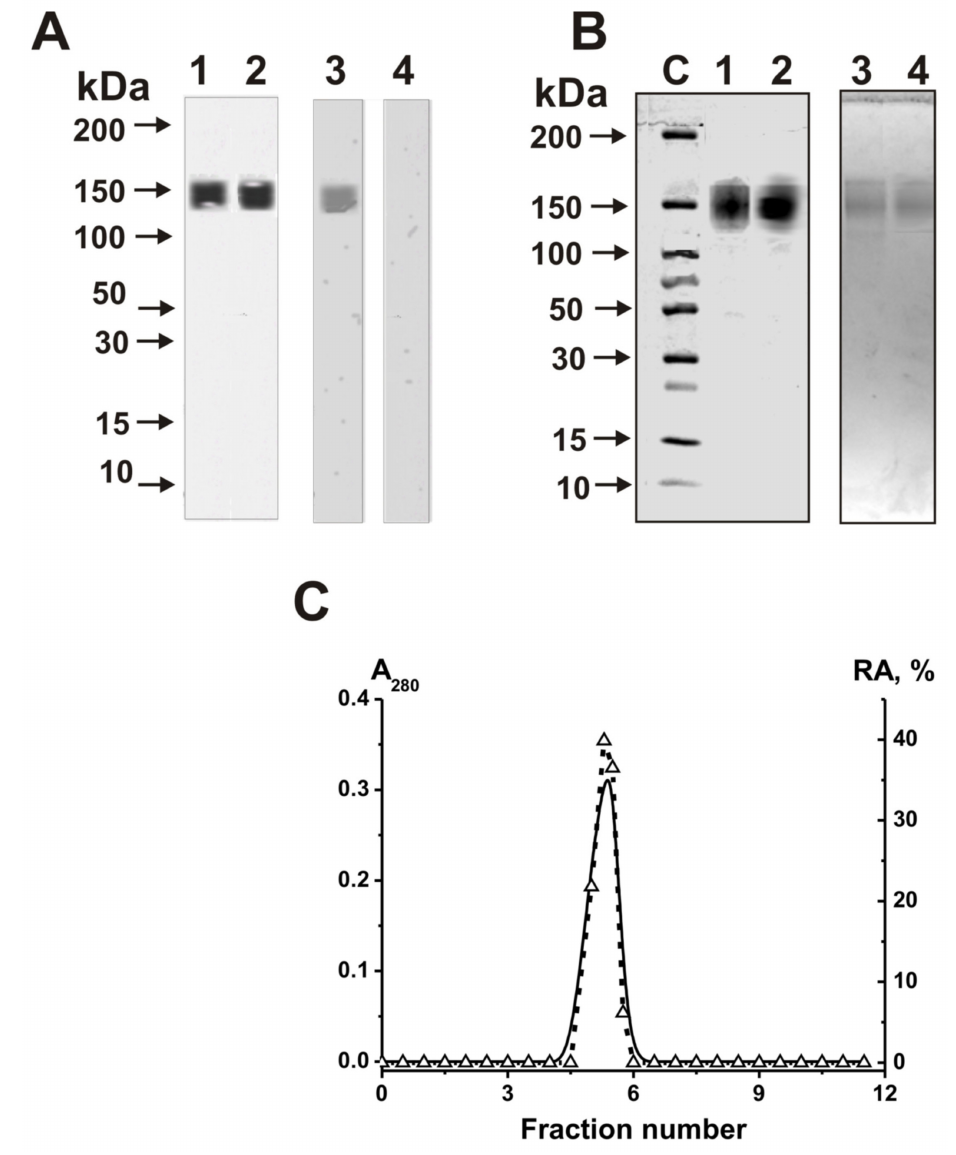
Figure 1. SDS-PAGE analysis of homogeneity of 12 µ g IgG1 (lane 1) and IgG mix corresponding to the mixture of seven individual IgGs (lane 2) in a nonreducing 3–18% gradient gel with the following staining by silver ( A ). IgG mix preparation was analyzed by standard Western blotting (A). After SDS-PAGE, IgG mix was transferred on nitrocellulose membrane. The membrane was treated with monoclonal mouse Abs (conjugated with horseradish peroxidase) against human IgGs (lane 3) or ribonuclease A (lane 4). Strict criteria verification was performed to prove that the ribonuclease activities of IgG1 and IgG mix are their intrinsic properties. After SDS-PAGE of IgG1 (lane 1) and IgG mix (lane 2) in a gel containing polymeric RNA, SDS was removed, and the gel was stained with ethidium bromide. The gel sections containing no RNA due to hydrolysis were not stained; dark bands on a uniformly fluorescent background, lanes 3 and 4 of Panel B . A part of the gel was stained with Coomassie R250 to show the position of intact IgGs (lanes 1 and 2) ( B ). Lane C shows the positions of protein molecular mass markers (B). Analysis of IgG mix ribonuclease activity; (–) – A 280 profile; ( ∆ ), relative activity (%) of IgG mix in the hydrolysis of 5’-Flu-miR-137 after Abs FPLC gel filtration in acidic bu ff er (pH 2.6) ( C ). Complete hydrolysis of the substrate for 7 h was taken for 100%. The error in RAs from two experiments did not exceed